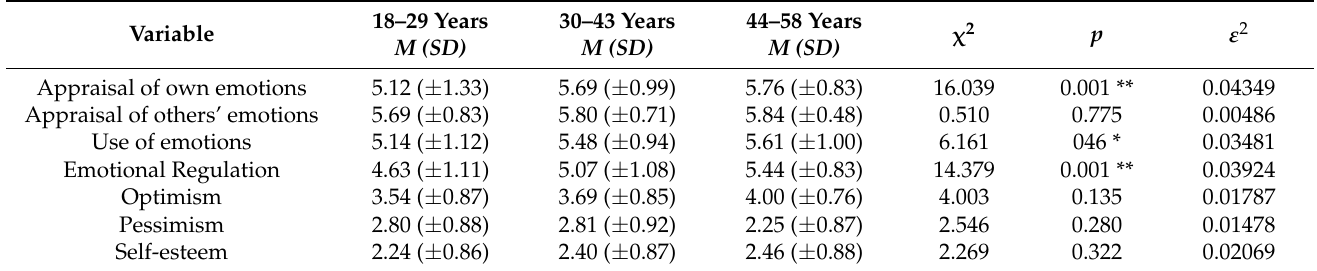
Table 4. Rank differences according to age (H of Kruskal-Wallis Test).